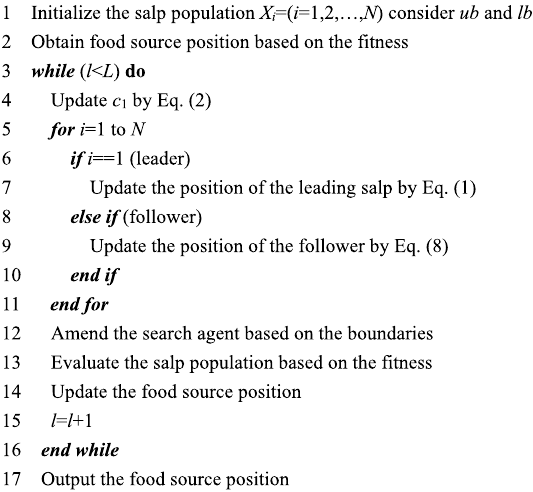
Algorithm 1. Q -Pseudocode of SSA.